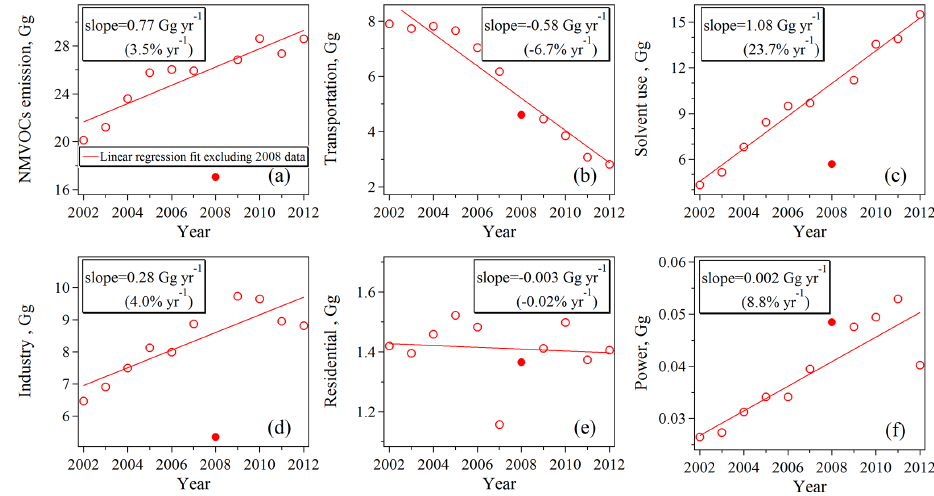
Figure 1. Anthropogenic NMVOC emissions in Beijing during August from 2002 to 2012 reported by the MEIC inventory (http://www. meicmodel.org): (a) total emissions, (b) transportation, (c) solvent use, (d) industry, (e) residential activities, and (f) power plants. Owing to the influence from the short-term control measures for the Beijing Olympic Games, the emission data for August 2008 (the red filled circle) were excluded from the linear regression fits (the red solid lines). Table 1. Summertime NMHC measurements data sets at the PKU site in Beijing from 2002 to 2013. Year Instruments Observation period (time resolution)